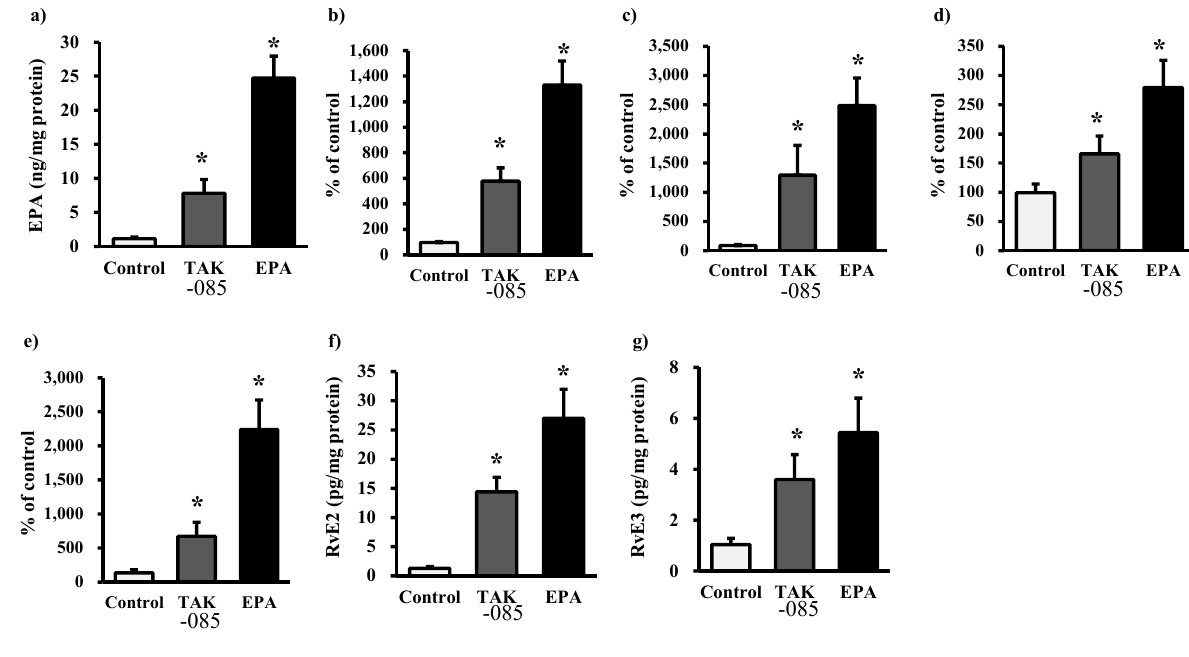
Figure 4. Renal levels of EPA-derived eicosanoids. ( a ) Nonesterified EPA, ( b ) 5-HEPE, ( c ) 12-HEPE, ( d) 15-HEPE, ( e ) 18-HEPE, ( f ) RvE2, and ( g ) RvE3. Values are presented as mean ± SE (n = 10–11). Statistical analysis was performed by one-way ANOVA followed by Dunnett’s test. * P < 0.05 vs. control